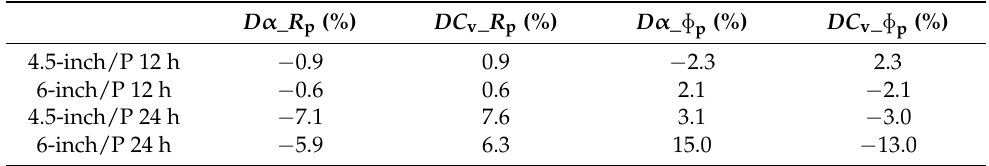
Table A3. Thermal diffusivity and heat capacity deviation D (%) from the expected 0.70 mm 2 s − 1 and 2.43 MJ m − 3 K − 1 ,